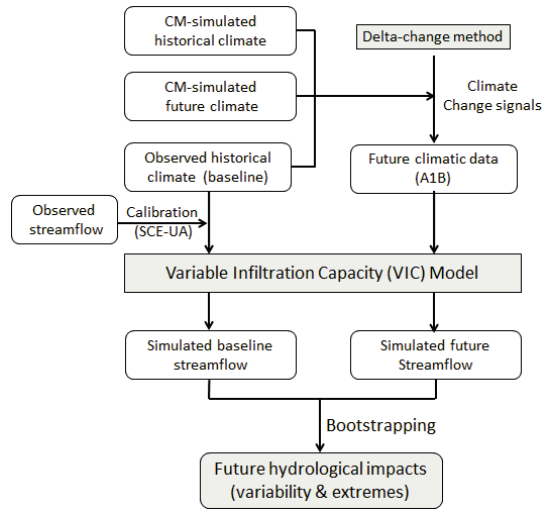
Fig. 1 Modelling framework for assessing possible future climate change impacts on